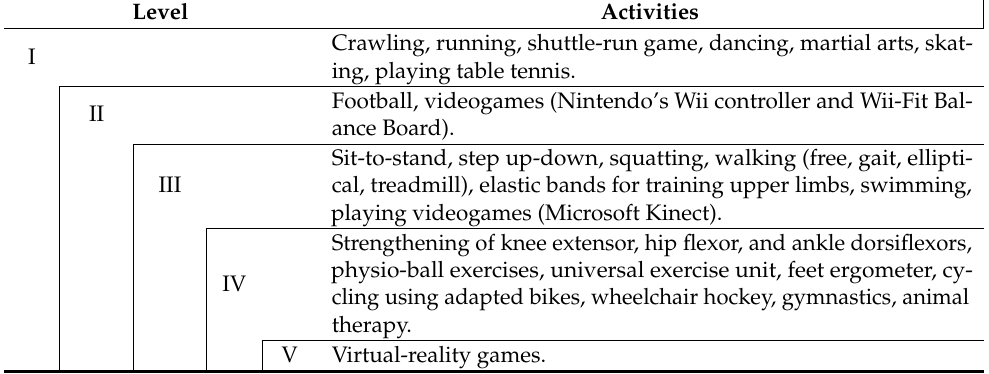
Table 6. Overview of physical activities by motor functionality. Each level contains the activities of higher